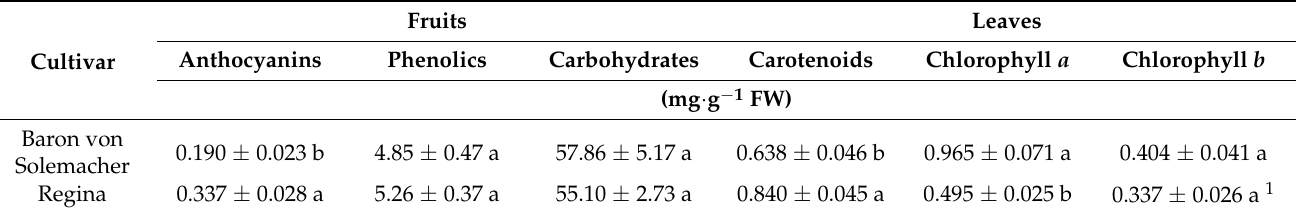
Table 6. Contents of pigments (anthocyanins, carotenoids, chlorophyll a , chlorophyll b ), phenolics, and carbohydrates in fresh fruits or leaves of two wild strawberry